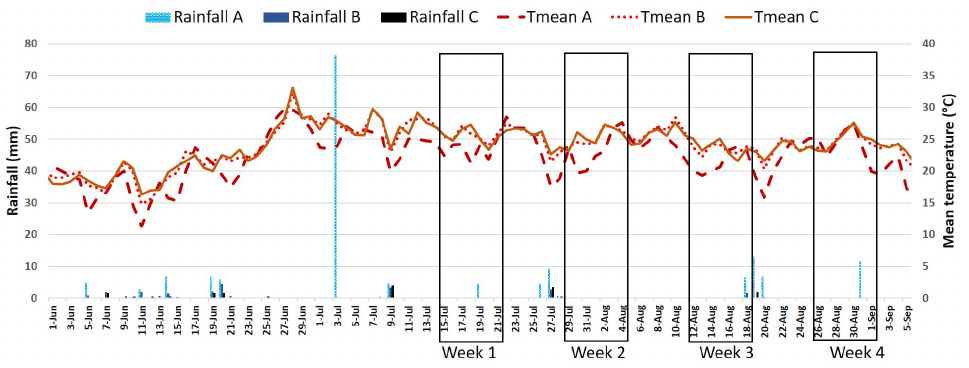
Figure 5. Diagram showing rainfalls and temperatures for the 3 locations in relation with measure- ments periods (week 1 to 4). Tmean refers to the mean temperature for each